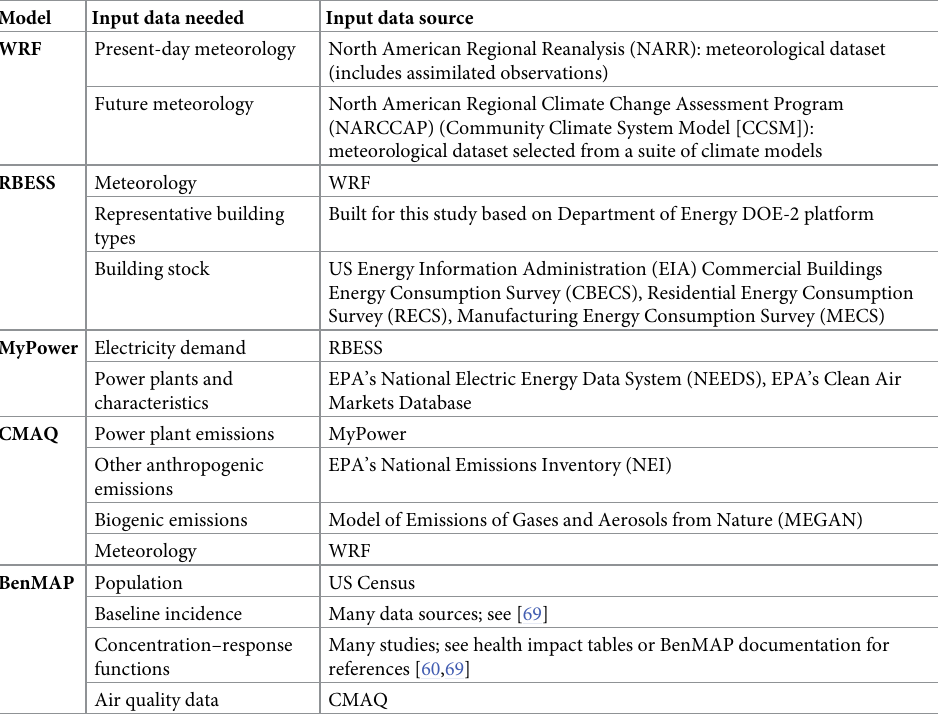
Table 1. Major data inputs and sources for each step of the modeling